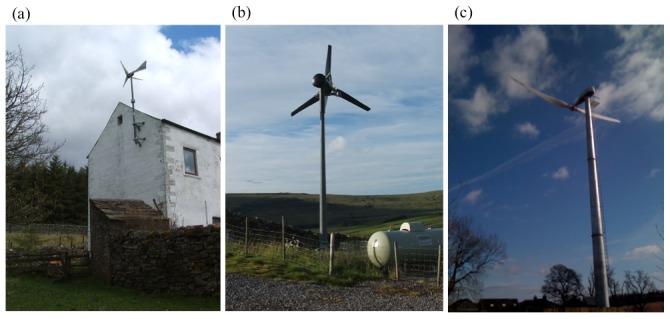
Three examples of turbine models studied.(a) a 10 m high building-mounted model with three blades and a diameter of 1.75 m, (b) a 6.5 m high free-standing model with three blades and a diameter of 3.5 m, (c) a 18 m high free-standing model with two blades and a diameter of 13 m.